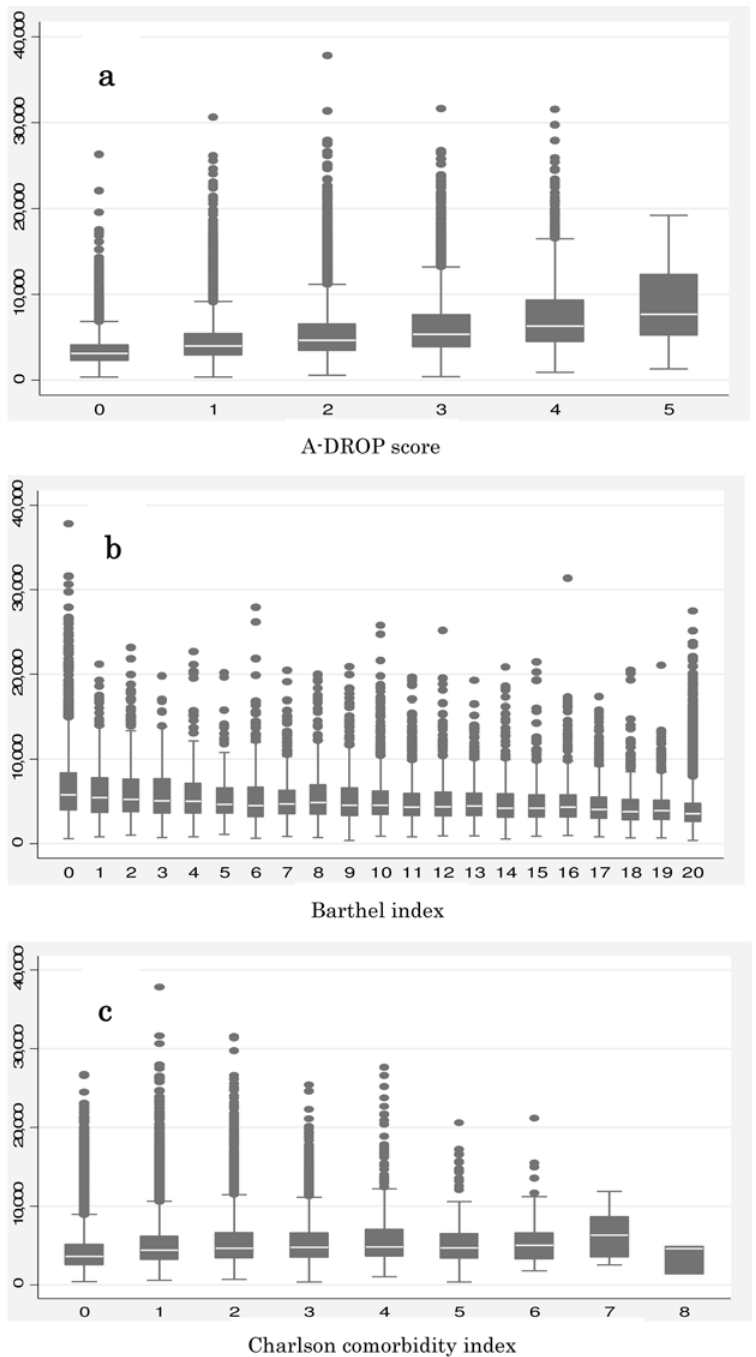
Fig 3. Box plots of hospital costs by patient severitys. (a) Box plot of hospital costs by A-DROP score (b) Box plot of hospital costs by Barthel index (c) Box plot of hospital costs by Charlson comorbidity index. All horizontal axes indicate total hospitalization costs(US$) and the vertical axes indicate (a) A-DROP score (b) Barthel index (c)Charlson comorbidity index.